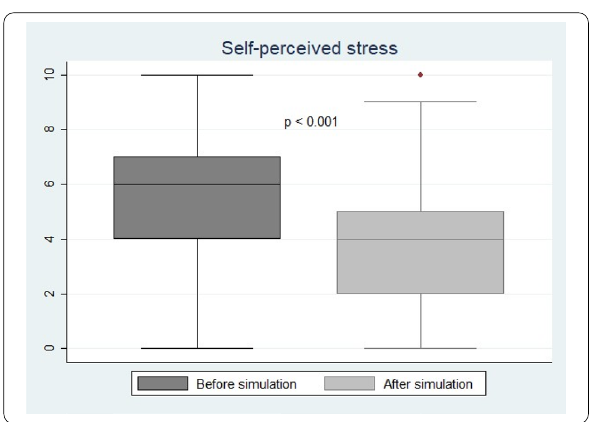
Figure 1. Box plot showing overall pediatric intensive care team stress related to family member presence during cardiopulmonary resuscitation or other major interventions in the pediatric intensive care unit, before and after the